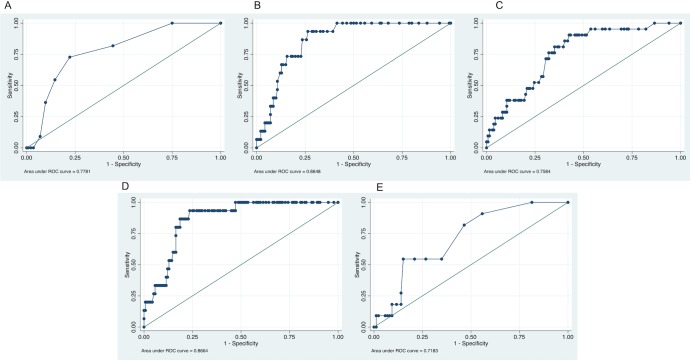
ROC curves for the different algorithms adapted according to EULAR indications.Areas under the curve (AUC)-values (95% CI) are 0.7679 (95% CI 0.64768 to 0.88812), 0.8648 (95% CI 0.79675 to 0.93278), 0.7584 (95% CI 0.65889 to 0.85782), 0.8664 (95% CI 0.79452 to 0.93834), and 0.7183 (95% CI 0.57795 to 0.85862) for SCORE*1.5 (A), CUORE*1.5 (B), FRS*1.5 (C), QRISK2-RA (D), and RRS*1.5 (E), respectively.